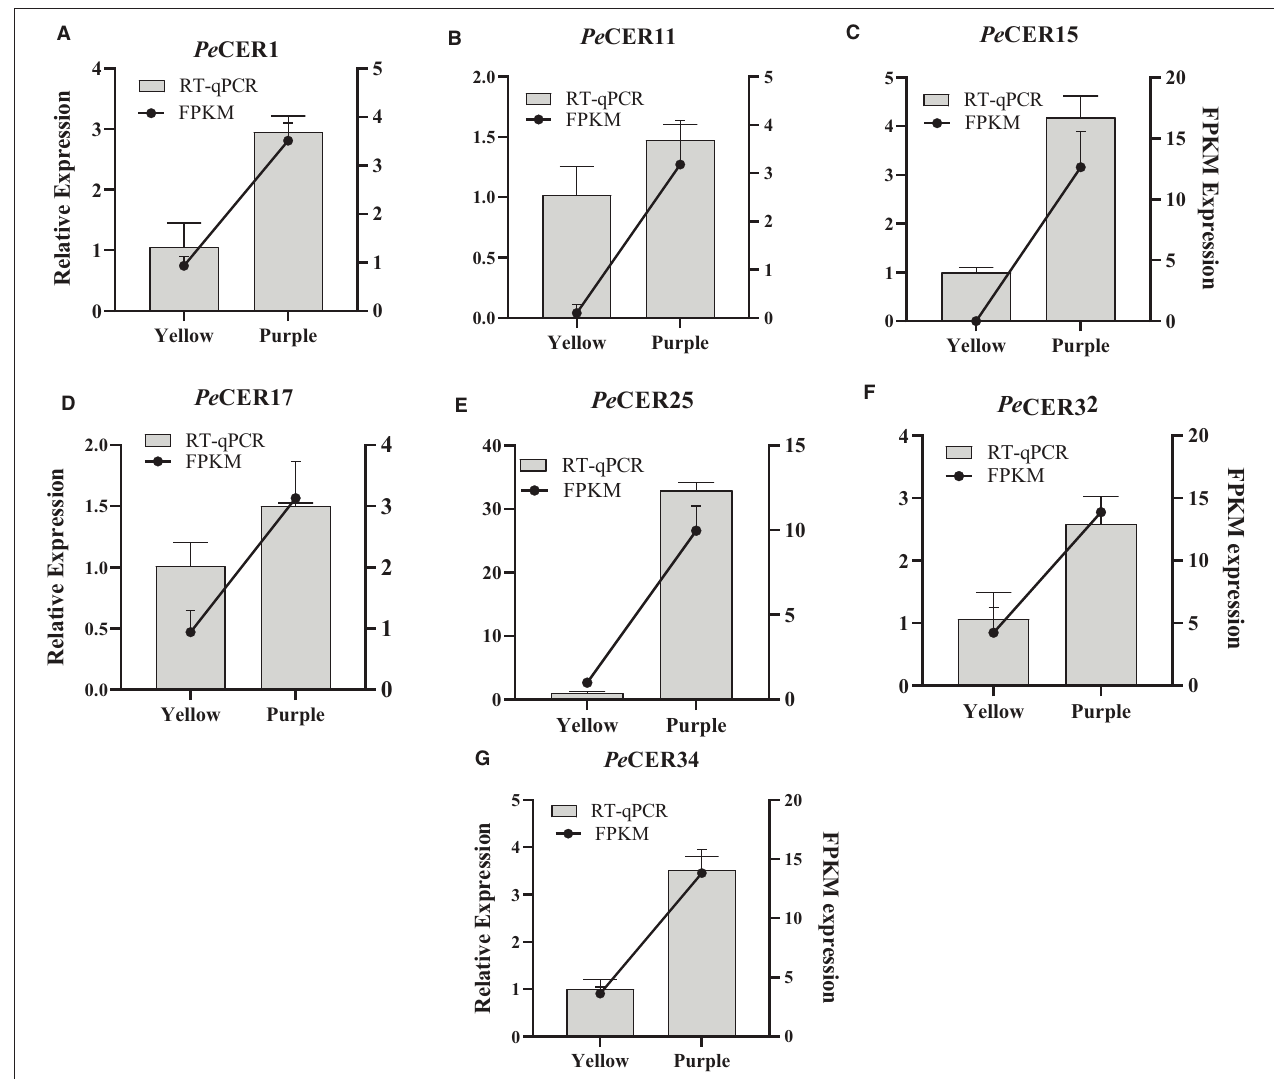
FIGURE 14 | Validation of FPKM expression data by qRT-PCR. (A–G) Histograms show the qPCR results of seven PeCER genes in peel tissues of yellow and purple passion fruit cultivars at the ripening stage. Black line charts show the FPKM values of PeCER genes, and vertical gray bars show the qPCR results (2 − 11 ct ) and represent mean ± SD. The left Y-axis represents the qPCR relative expression levels, and the right Y-axis indicates the FPKM expression